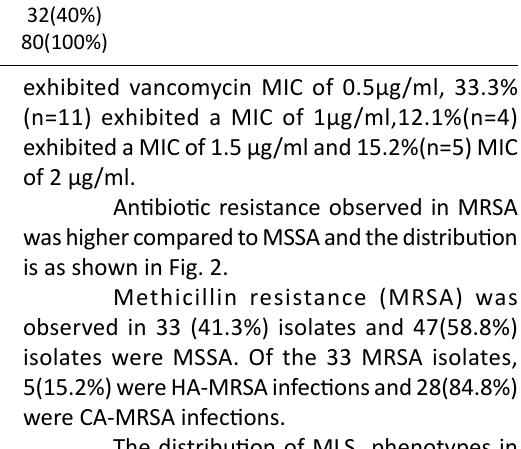
Table 2. Distribution of MLS Oganisms